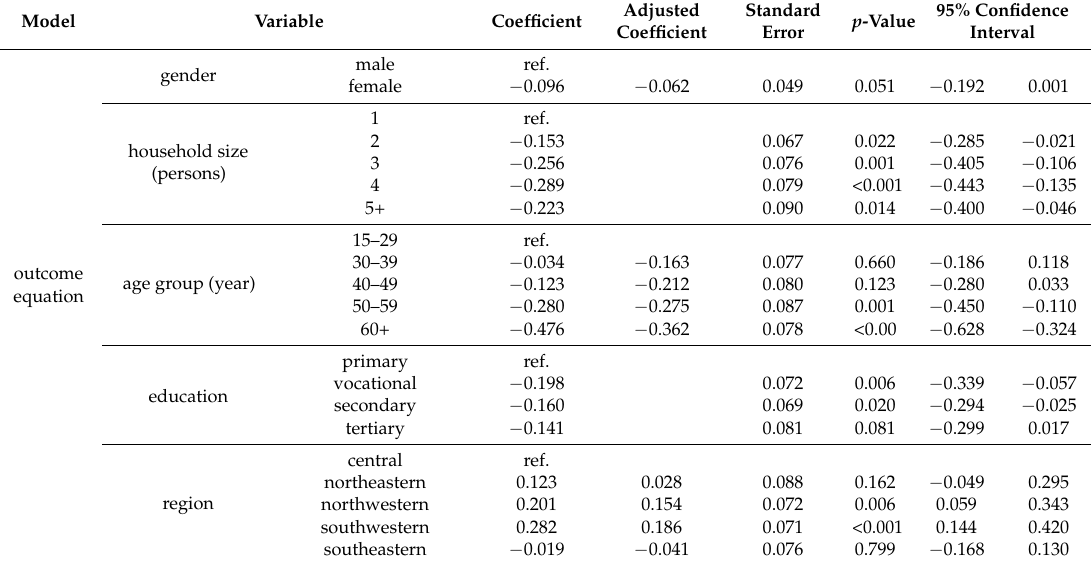
Table 5. Impact of living in a rural area and farming on physical activity—estimates of Heckman selection